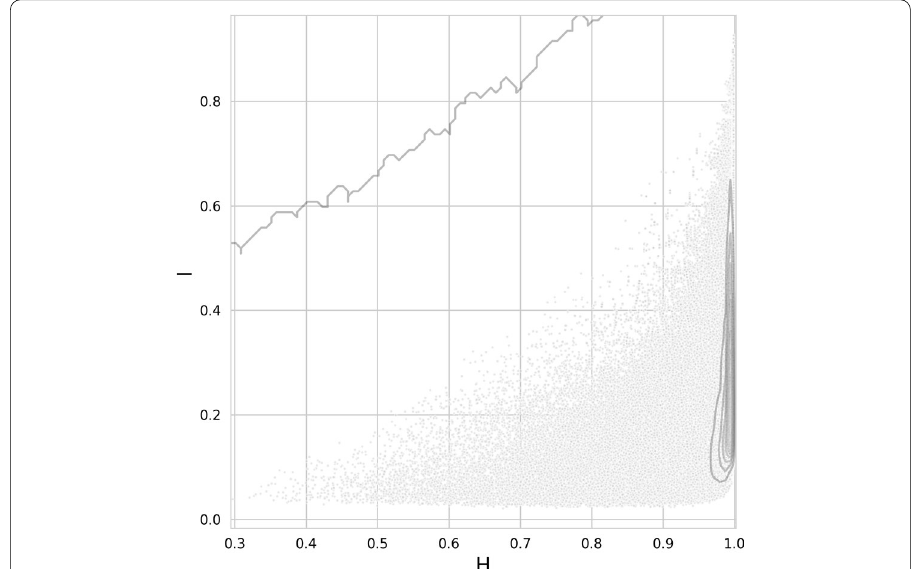
Fig. 11 Homogeneity and intensity H × I results on 1,329,696 synthetic multiplex networks considering their transition coupling with density lines (Gaussian kernel density